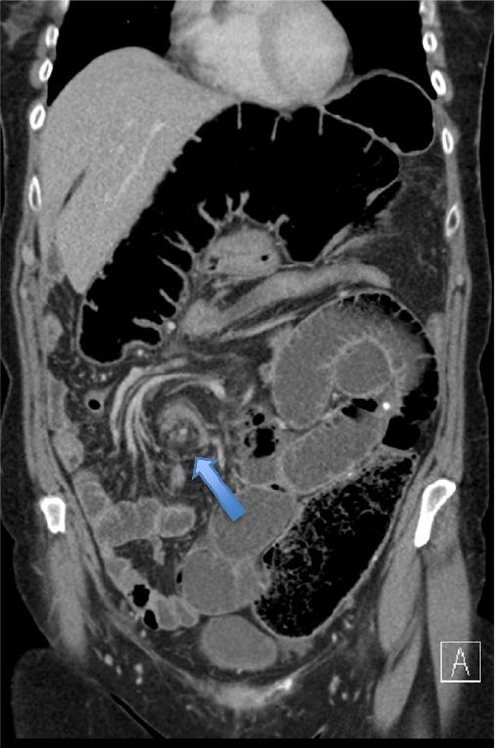
Figure 10. CT coronal image showing a typical whirl sign (blue arrow).